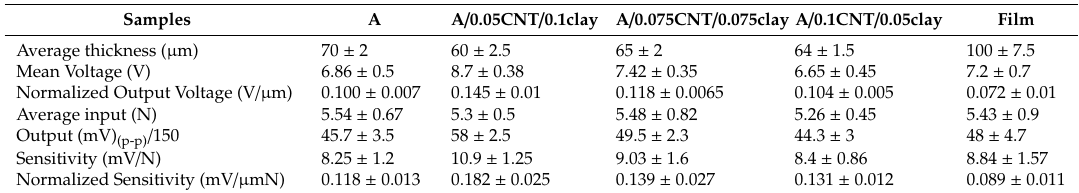
Table 4. Output voltage p-p (peak to peak) and piezoelectric characteristics of hybrid nanocomposites. Reprinted with permission from